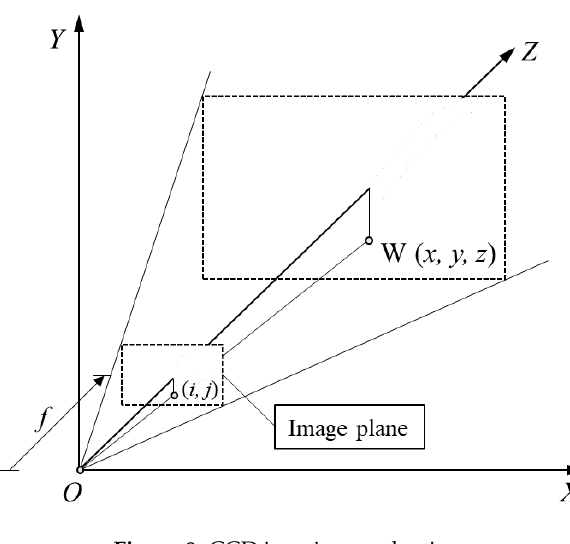
Figure 8. CCD imaging mechanism.